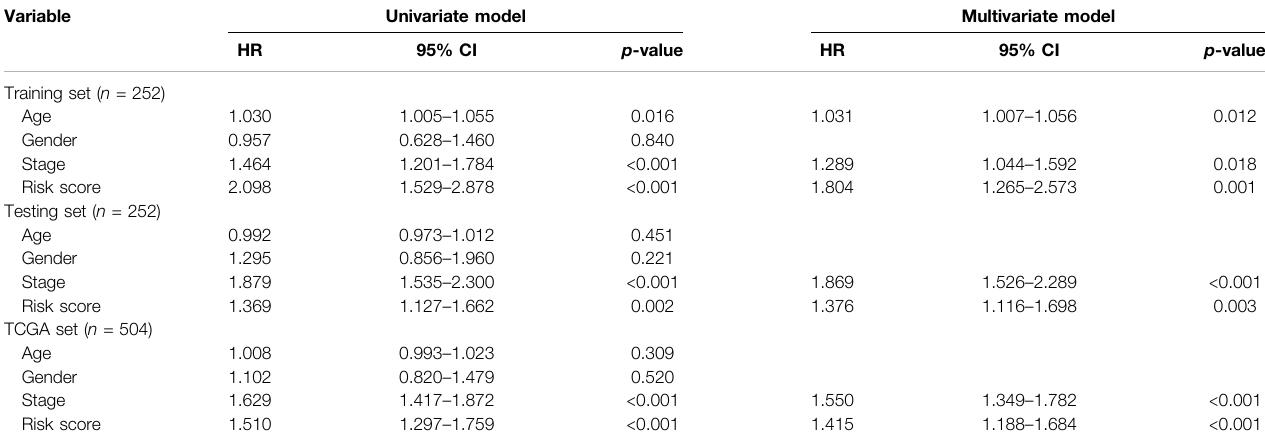
TABLE 3 | Univariate and multivariate Cox regression analysis of the MHLncSig and prognosis.